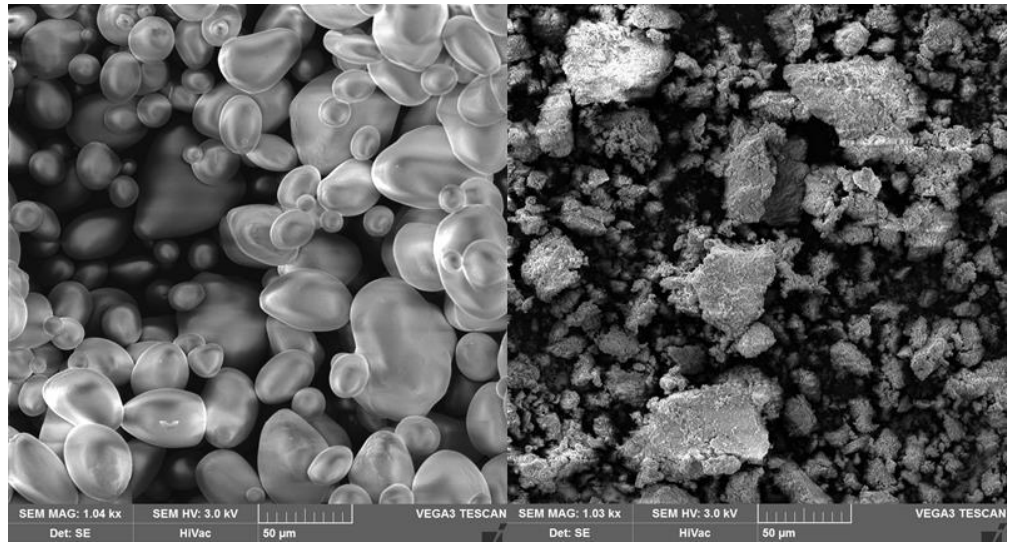
Figure 4. Destruction of potato starch grains after gelatinization in [BMIM]Cl (Jan Dlugosz University, Czestochowa